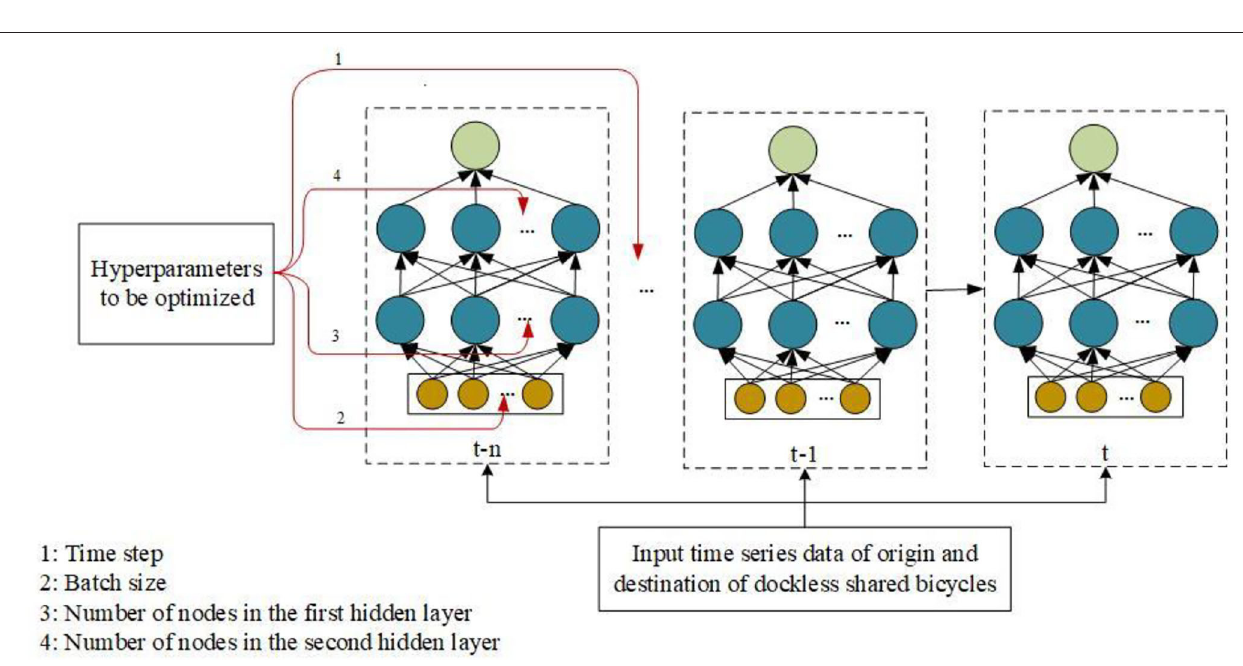
FIGURE 5 | Parameters to be optimized in the prediction network: 4 parameters are selected to be optimized.